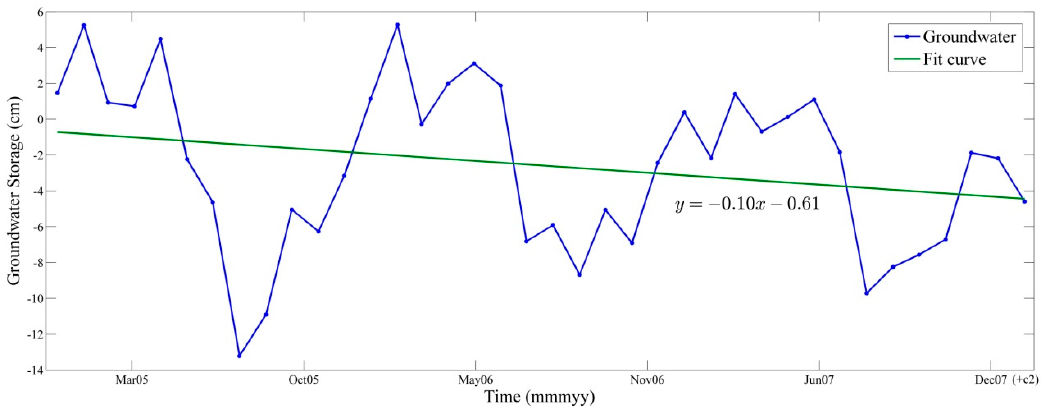
Figure 8. Variation in groundwater storage from January 2005 to February 2008.